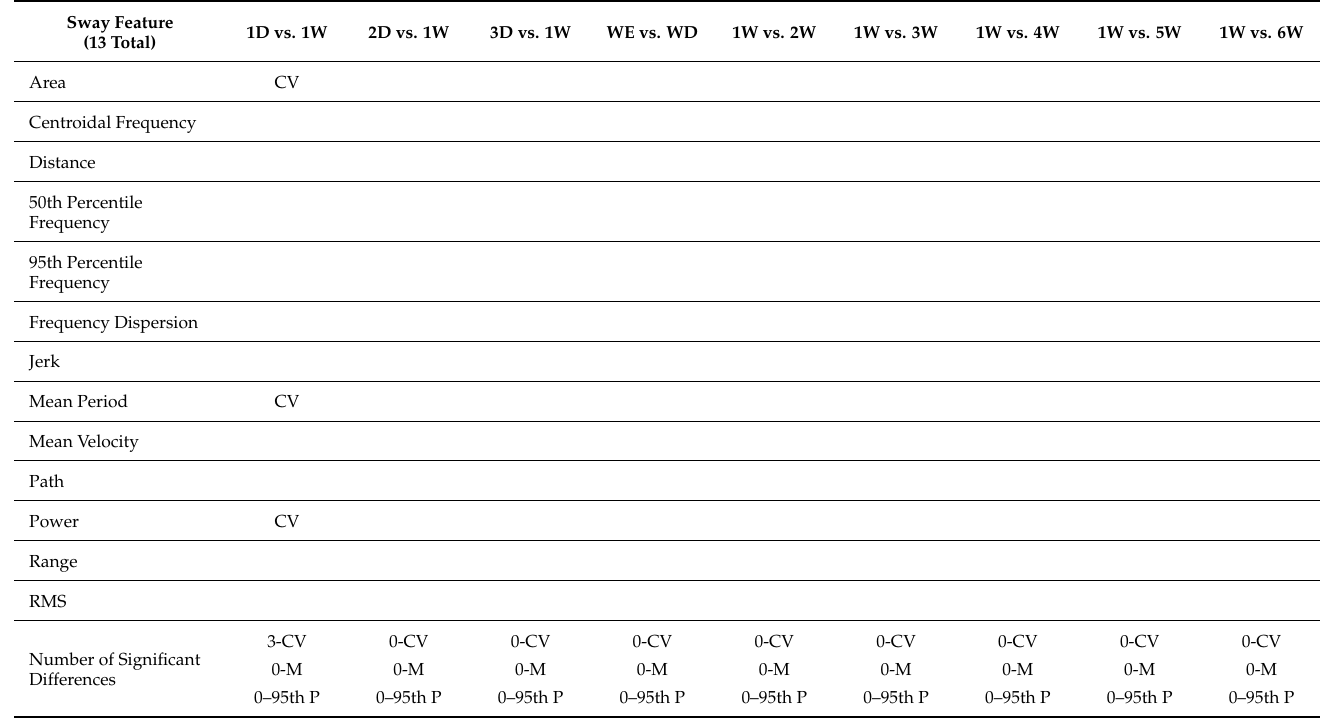
Table A2. Sway feature rank sum difference testing in persons with